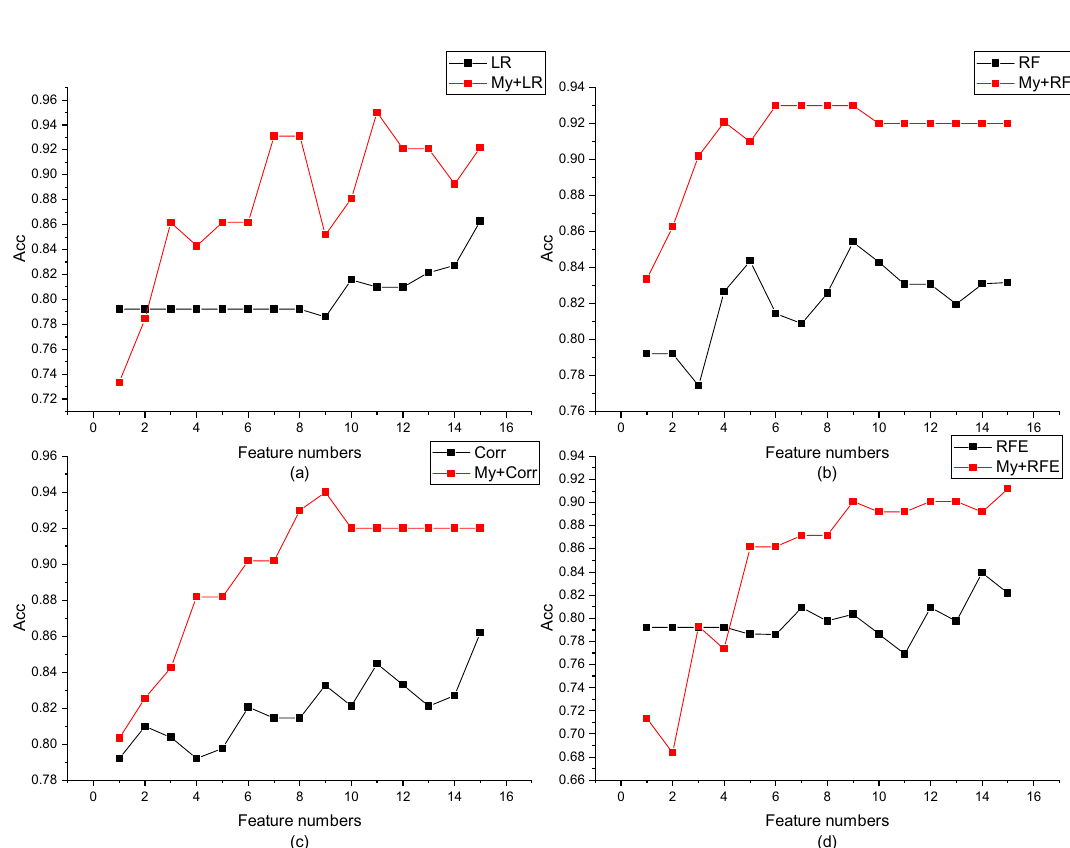
Figure 3. The proposed method is compared with the traditional method in the DLBCL dataset. Figures ( a ) to ( d ) compare logistic regression model (LR), random forest (RF), Pearson correlation coefficient (Corr) and recursive feature elimination method